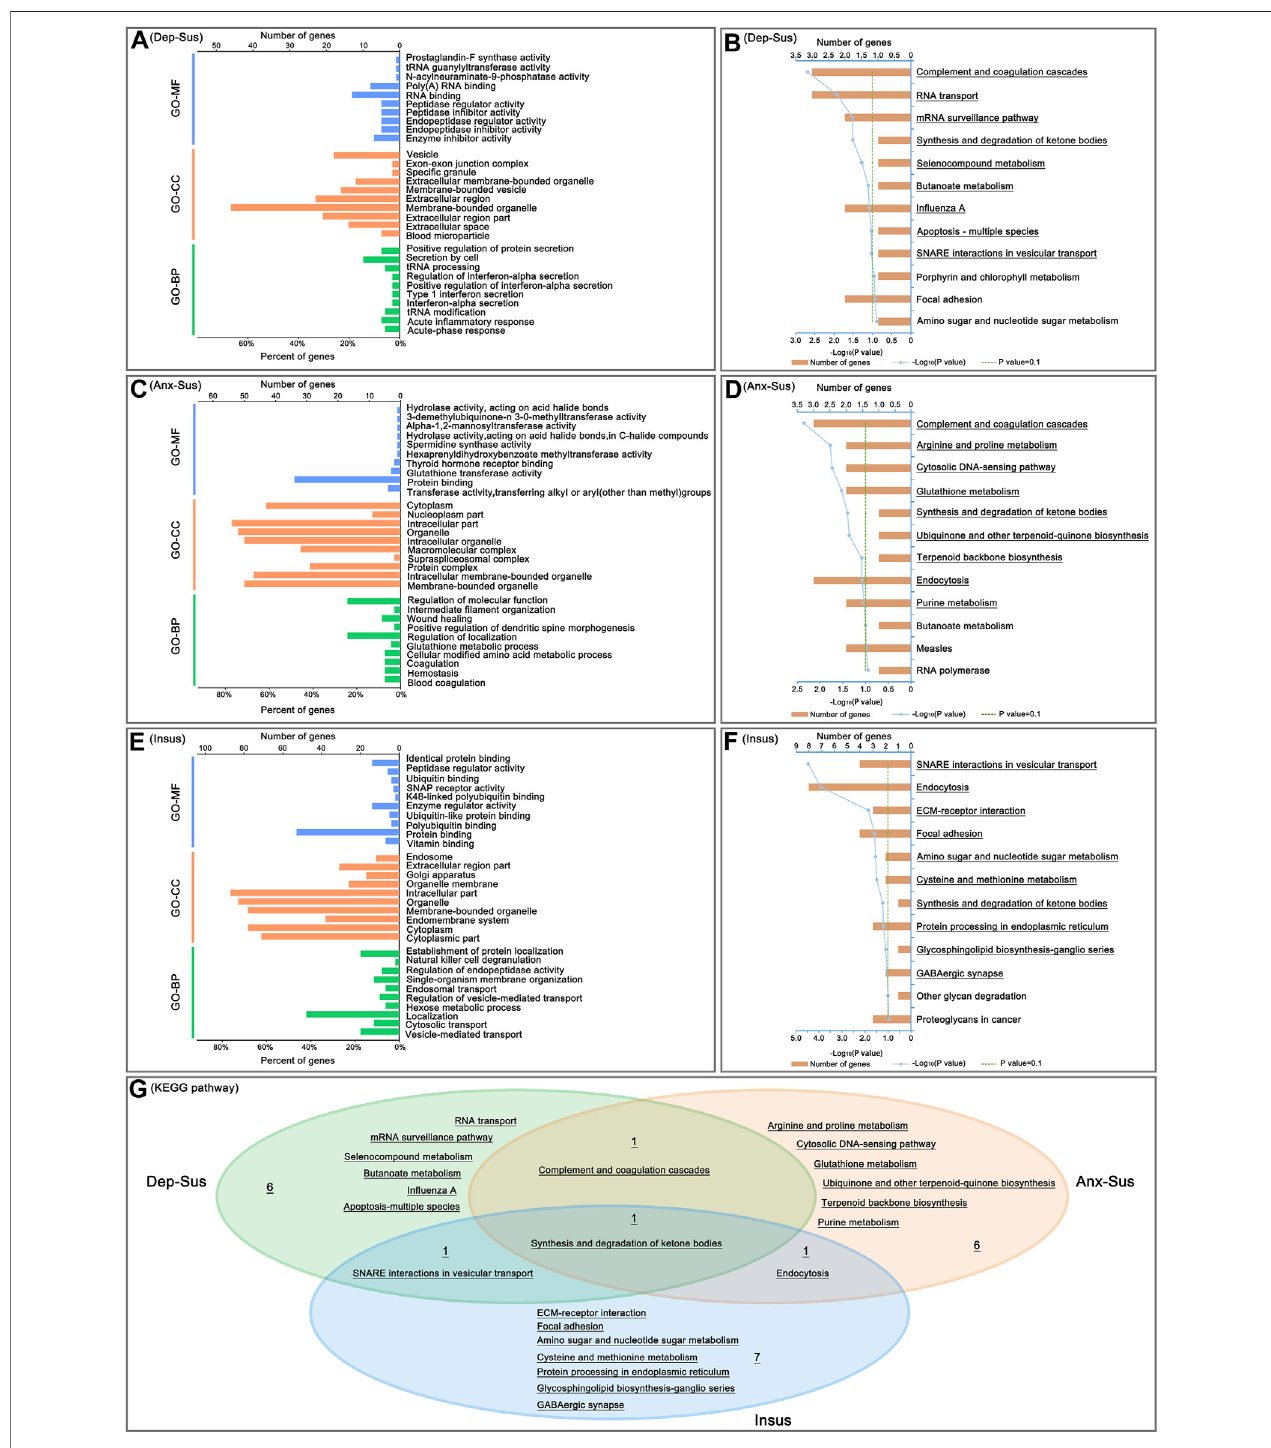
FIGURE 3 | Analysis of Gene Ontology (GO) and Kyoto Encyclopedia of Genes and Genomes (KEGG) pathway enrichments. The top ten enriched GO biological process (GO-BP), cellular component (GO-CC) and molecular function (GO-MF) terms of the deregulated pituitary proteins from the depression-susceptible (Dep-Sus, A ), anxiety-susceptible (Anx-Sus, C ) and insusceptible (Insus, E ) groups were indicated. Meanwhile, the signi fi cantly overrepresented KEGG pathway terms from the Dep-Sus (B) ,Anx-Sus (D) ,andInsus (F) groupswereshownwithunderscores.Thex-axisrepresented thenegativelog10-transformed p -value. (G) Venndiagram displaying unique and common signi fi cantly-enriched pathways among the three groups.